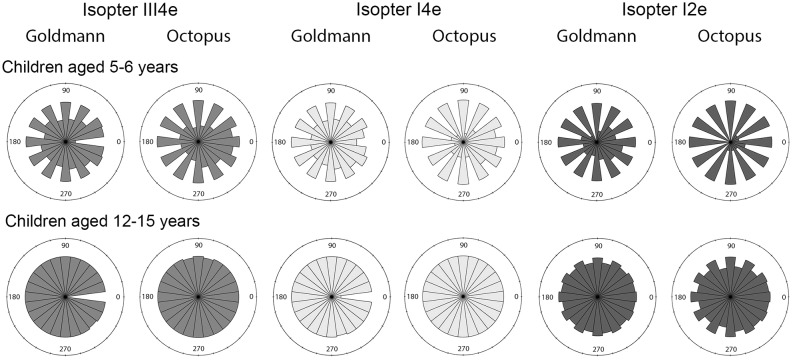
Rose diagrams of the frequency of points plotted along individual meridians for Goldmann and Octopus perimetry for children aged 5–6 years compared to 12–15 years.A larger area indicates a meridian with a larger number of plotted points. *The empty sectors at 0° for Goldmann perimetry isopters III4e and I4e correspond to the ‘void’ area in the perimeter bowl.